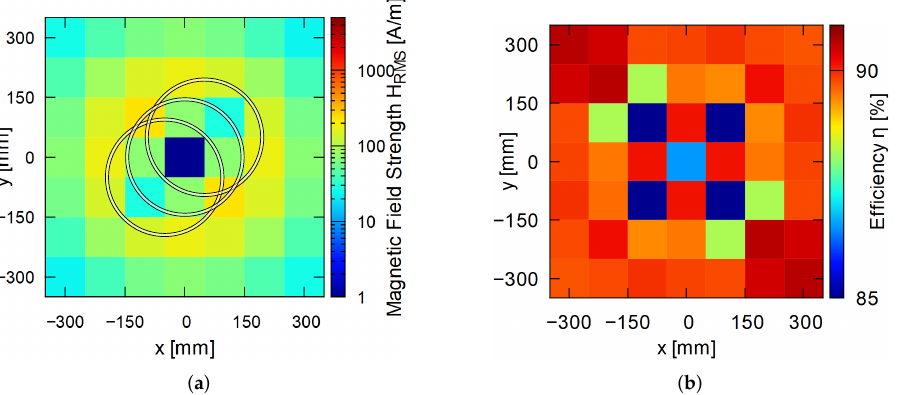
Figure 12. Color map ( α = 0.9, 3 Tx coils): ( a ) transmission (Tx) coil configuration and magnetic field strength map and ( b ) transmission efficiency map. The Tx coil configuration was as follows: Tx 1 , ( − 50, − 50, 0) mm; Tx 2 , (50, 50, 0) mm; Tx 3 , (0, 0, 0)